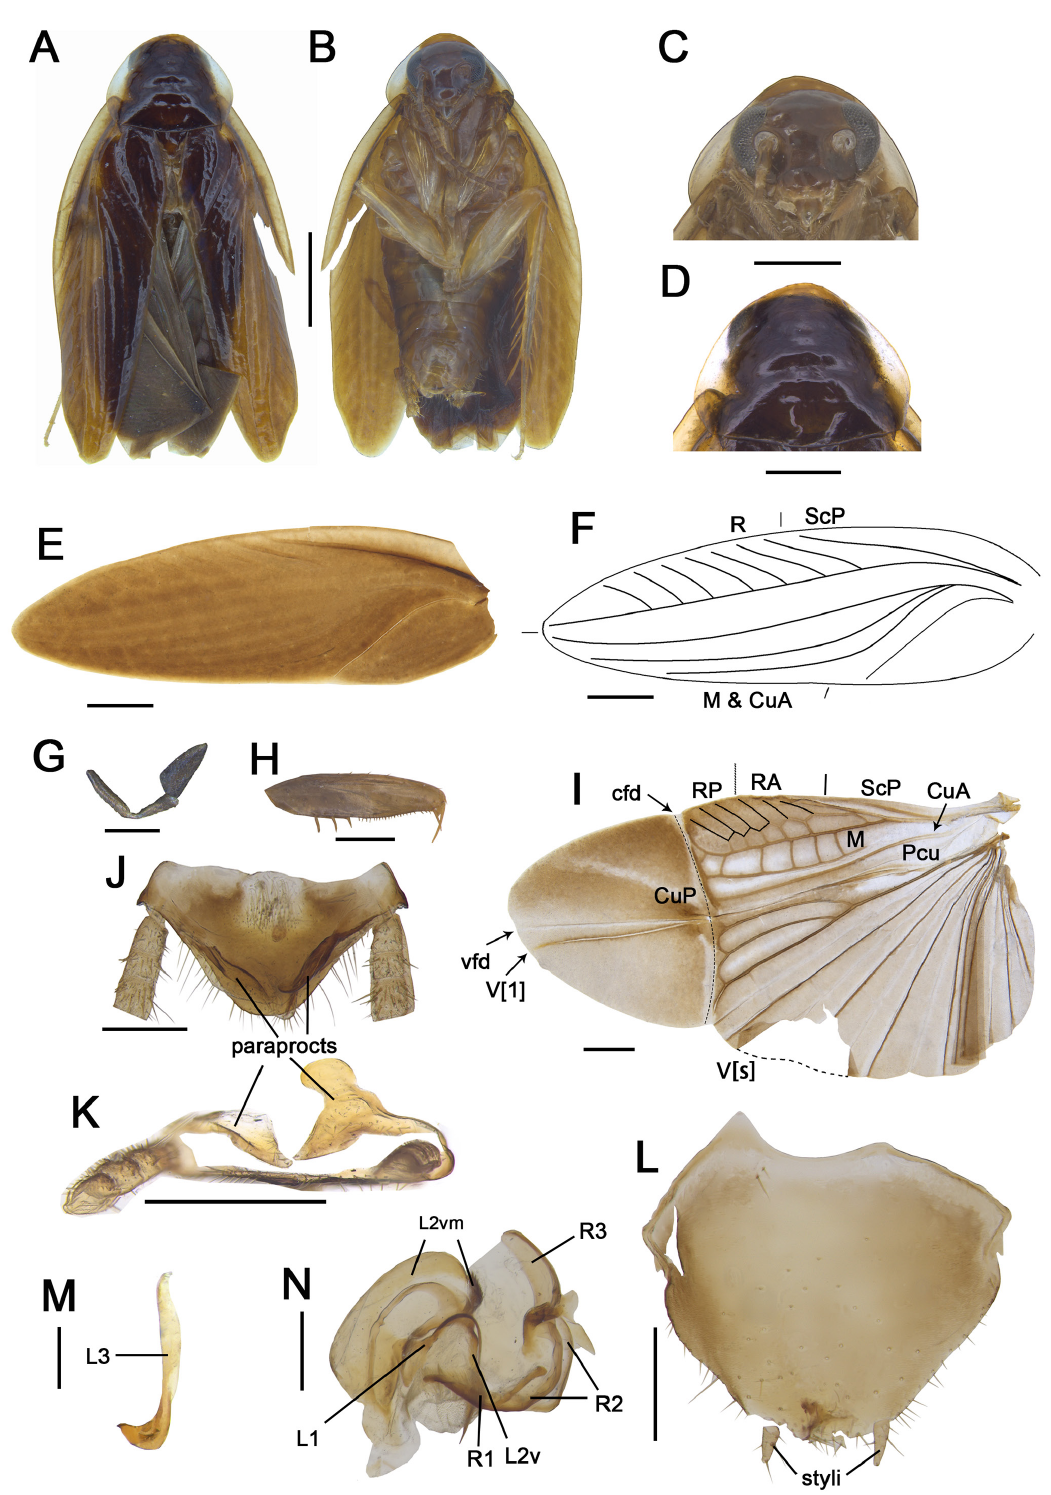
Fig. 6. Anaplecta furcata Deng & Che sp. nov., holotype, ♂ (SWU). A . Habitus, dorsal view. B . Habitus, ventral view. C . Head, ventral view. D . Pronotum, dorsal view. E . Tegmina. F . Tegmina vein. G . Maxillary palp. H . Front femur, ventral view. I . Wings. J . Supra-anal plate, dorsal view. K . Supra-anal plate. L . Subgenital plate, ventral view. M . Hook, ventral view. N . Left and right phallomere, ventral view. Scale bars: A–B = 1 mm; C–F, H–N = 0.5 mm; G = 0.25